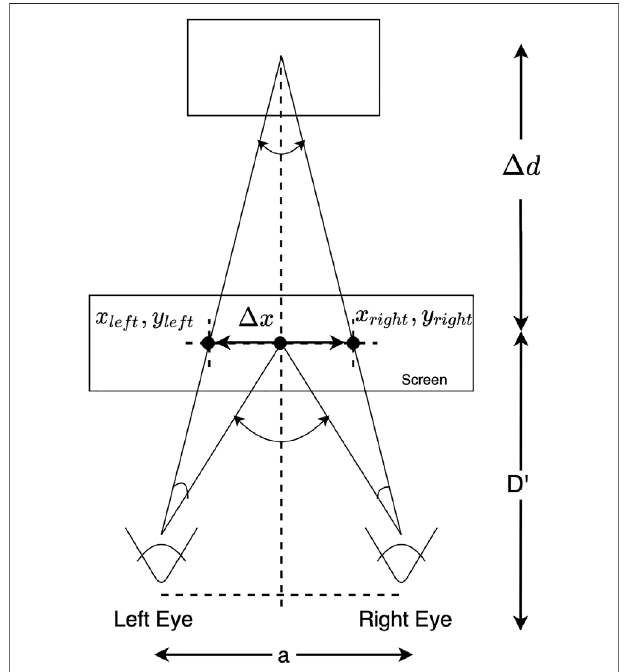
FIGURE5| Ocularvergence (Daughertyet al.,2010;Wanget al.,2012).